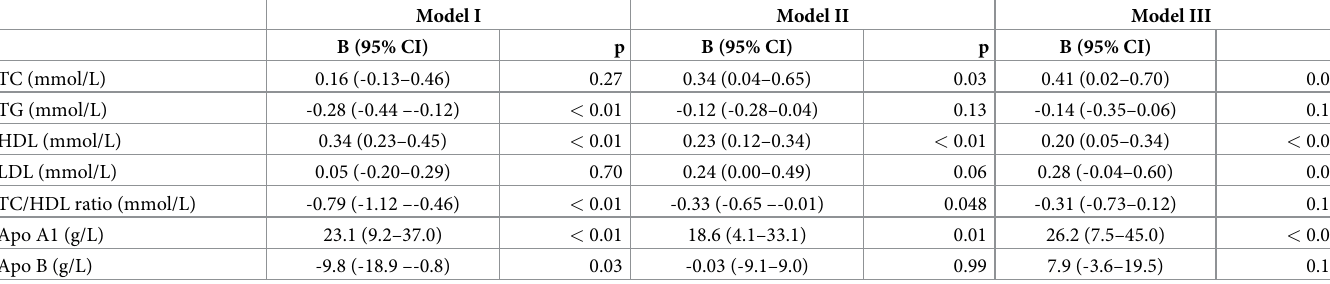
Model 2: adjusted for BMI, fasting glucose Model 3: adjusted for BMI, fasting glucose, season, ethnicity and age 25(OH) D, 25-hydroxy vitamin D; Apo, apolipoprotein; HDL, high density lipoprotein; LDL, low density lipoprotein; TC, total cholesterol; TG,